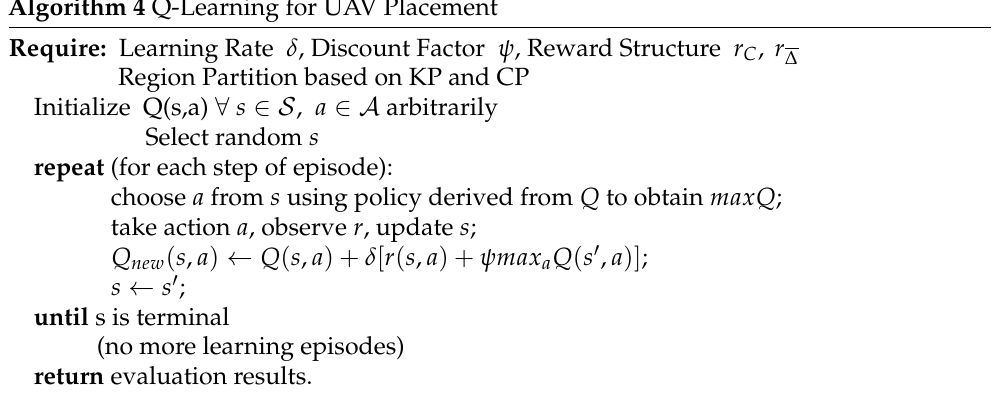
Algorithm 4 Q-Learning for UAV